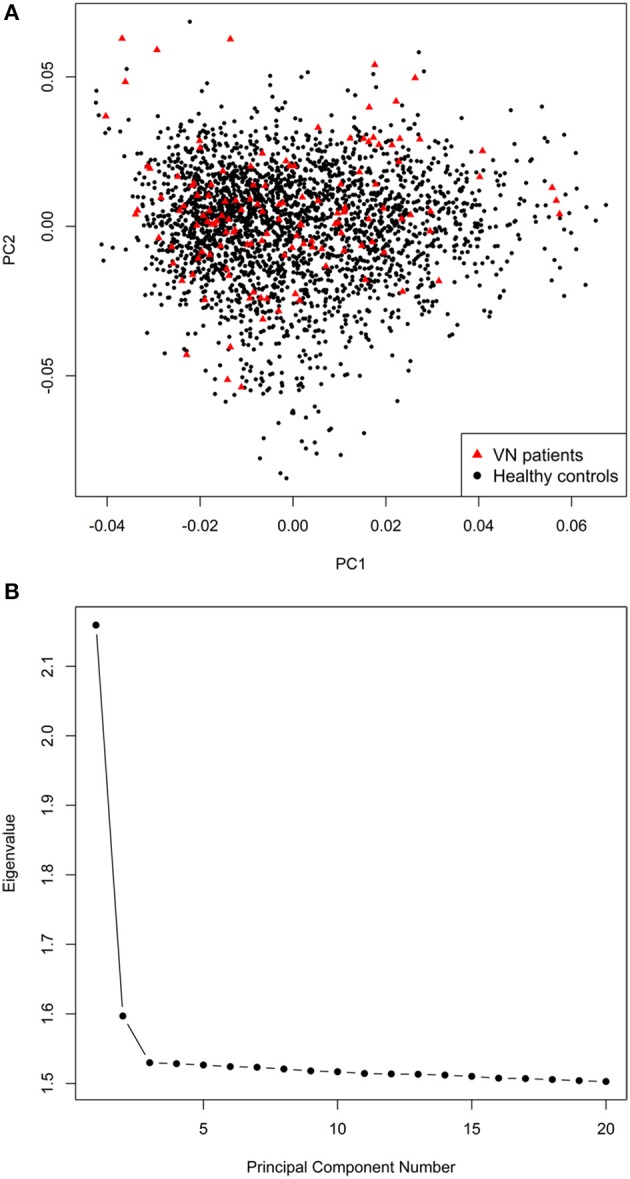
(A) Scatterplot of the first two principal components derived by EIGENSTRAT. (B) Scree-plot of principal components 1–20 derived by EIGENSTRAT.